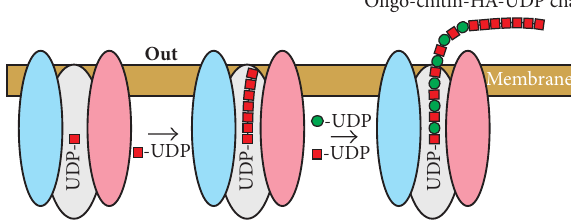
Figure 4: HAS initiation of HA synthesis using a self-made oligo- chitosyl-UDP primer results in HA chains with a chitin oligosaccha- ride cap at the nonreducing end. HAS makes chitin oligomers when incubated with GlcNAc-UDP (red squares) alone. We found that the enzyme first makes chitin oligomers linked to UDP at the reducing end [61], consistent with the mechanism of addition at the reducing end, and that these molecules could then serve as self-primers for HA disaccharide synthesis (GlcUA; green